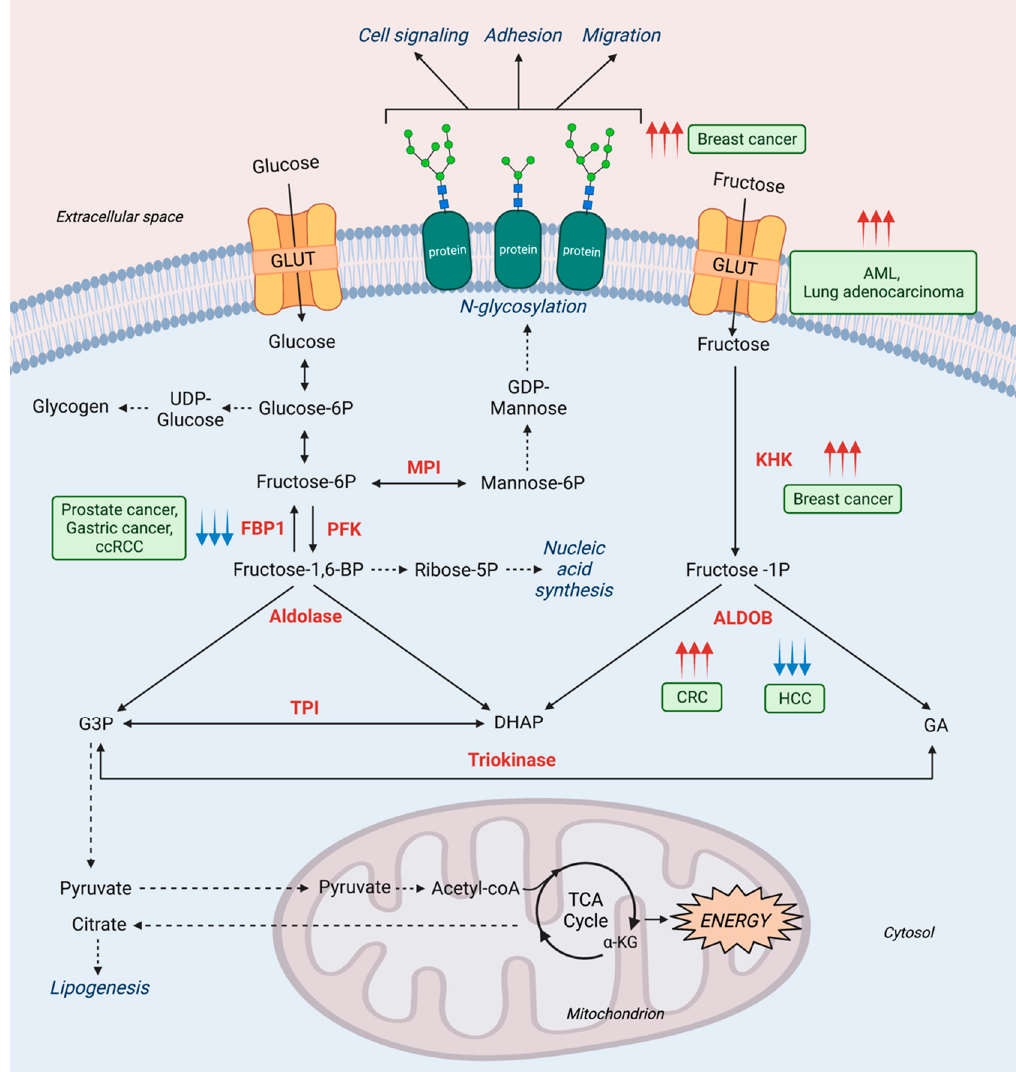
Figure 3. Fructose metabolism in cancer. Cancer cells reprogram their metabolism to support the greater energy demand for cell growth and proliferation. Often, fructose can be used as an alternative fuel source in low glucose conditions. The ability of fructose to be metabolized through various pathways (i.e., glycolysis, gluconeogenesis, glycosylation, nucleic acid synthesis, lipogenesis) paves the way for a number of metabolic alterations to occur in cancer, which are shown in the diagram above. The upregulation of cell membrane transporters, such as GLUT, induce increased fructose metabolism. Furthermore, the altered expression of enzymes, such as KHK, FBP1, and ALDOB, contribute to substantial clinical presen- tation of tumor progression in cancers, such as breast, prostate, gastric, ccRCC, and CRC. Enzymes are shown in bold red, metabolites are black, pathway outcomes are italicized navy. Cancer types are shown in light green text boxes. Red and blue arrows are indicative of expression or activity being upregulated or downregulated, respectively. Proteins: GLUT, Glucose transporter; FBP1, Fructose-1,6-bisphosphatase 1; PFK, Phosphofructokinase; TPI, Triose-phosphate isomerase; KHK, Ketohexokinase; ALDOB, Aldolase B; MPI: Mannose phosphate isomerase; Metabolites: α KG, Alpha-ketoglutarate; GA, Glyceraldehyde; DHAP, Dihydroxyacetone phosphate; Ribose-5P, Ribose-5-phosphate; Glucose-6P, Glucose-6-phos- phate; UDP, Uridine diphosphate; Fructose-1P, Fructose-1-phosphate; Fructose-6P, Fructose-6-phosphate; Fructose-1,6- BP, Fructose-1,6-bisphosphate; Mannose-6P, Mannose-6-phosphate; GDP, Guanosine diphosphate; G3P, Glyceraldehyde- 3-phosphate; Pathways: TCA, Tricarboxylic acid. Disease: CRC, Colorectal cancer; HCC, Hepatocellular carcinoma; ccRCC, Clear cell renal cell carcinoma; AML, Acute myeloid leukemia.